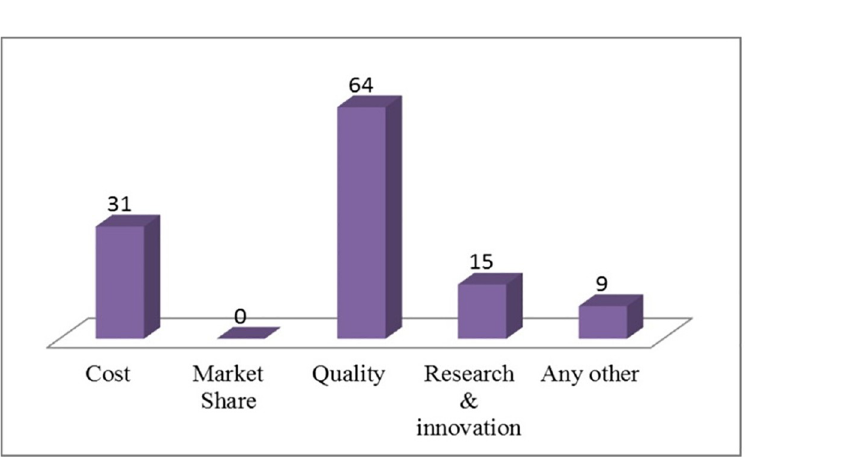
Fig 2. Factors align with organization’s strategic